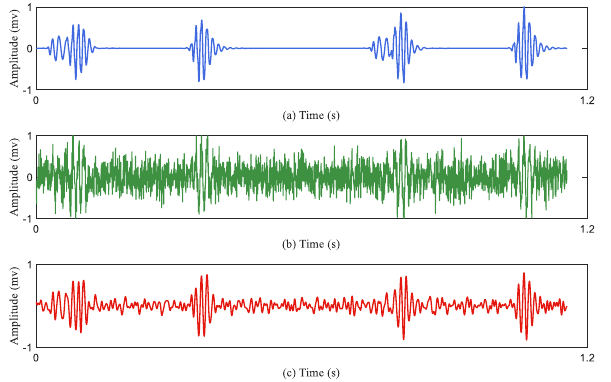
Figure 3. Examples of original PCG, augmented PCG and denoised PCG. ( a ) An original PCG signal (normal heart sound signal) after denoising; ( b ) an augmented PCG signal with noise; ( c ) a denoised PCG signal. Table 3. Recording distribution after data augmentation.